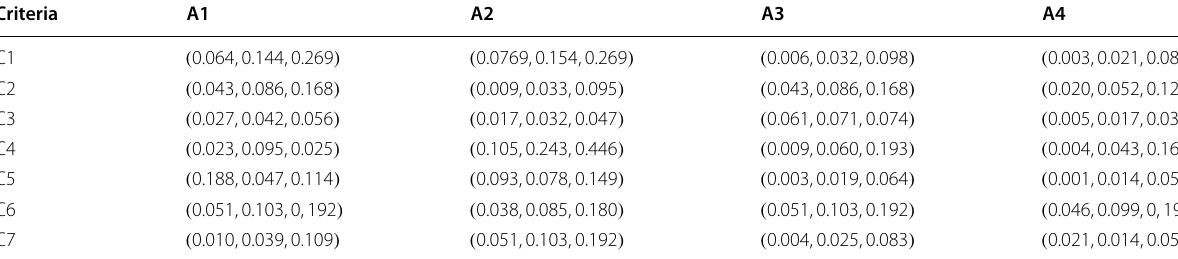
Table 11 Weighted normalized fuzzy decision matrix Criteria